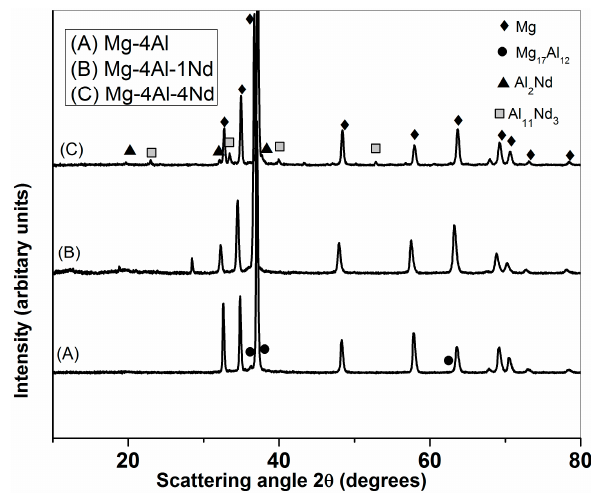
Figure 1. XRD pattern of as-cast alloys: ( A ) Mg-4Al, ( B ) Mg-4Al-1Nd, and ( C ) Mg-4Al-4Nd.